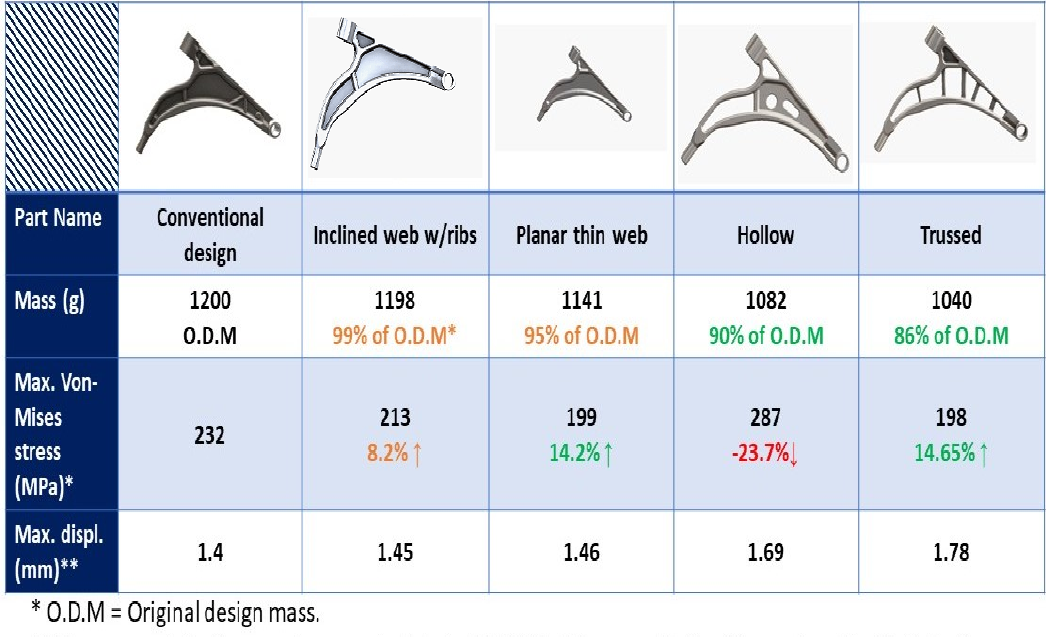
Figure 10. FEA of trussed design; ( a ) von Mises stress plot, ( b ) total displacement plot, ( c ) other view of Von Mises (VM) stress plot.